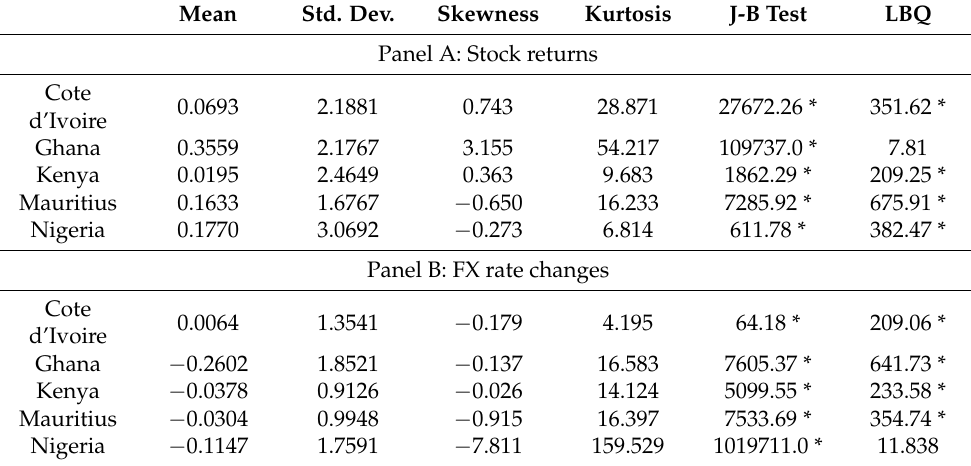
Table 2. Descriptive